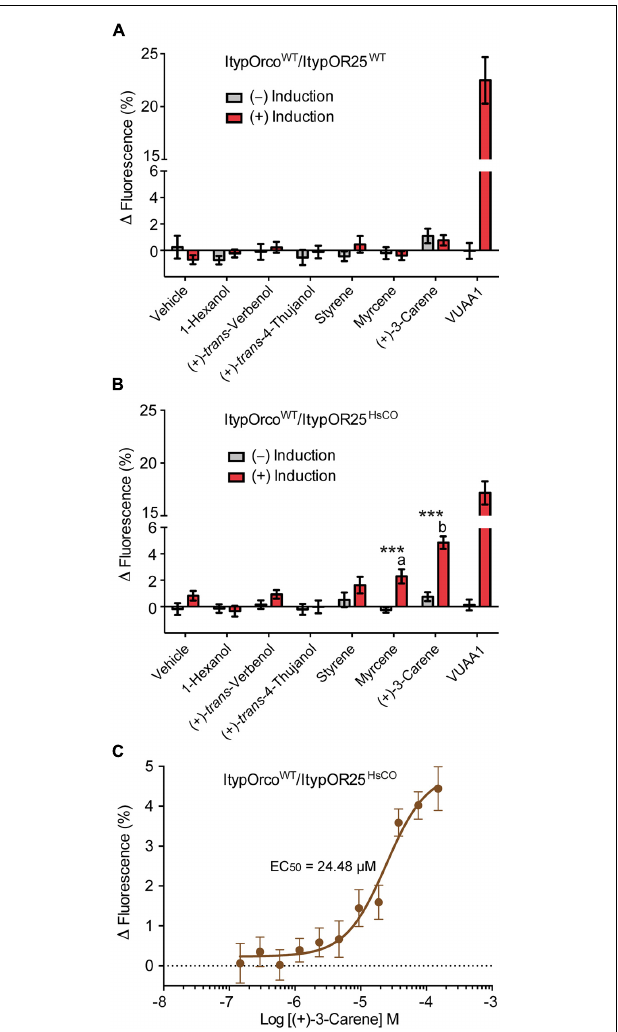
FIGURE 4 | Response of cells co-expressing wildtype I. typographus Orco (ItypOrco WT ) and wildtype or codon optimized (HsCO) ItypOR25 to select compounds. (A) ItypOR25 WT did not respond to any compound in the screening experiments (30 µ M concentration; n = 2 biological replicates; n total = 6). (B) ItypOR25 HsCO responded primarily to (+)-3-carene and secondarily to myrcene in the screening experiment ( n = 3 biological replicates, n total = 9). Asterisks (***) indicate significantly higher response in induced (+) versus non-induced ( − ) cells at p < 0.001, and different lowercase letters indicate significant differences between compounds at p < 0.001. (C) Dose-dependent response of ItypOR25 HsCO to (+)-3-carene ( n = 3 biological replicates; n total = 9). Error bars show SEM. Responses of ItypOR25 WT and ItypOR25 HsCO to the full odor panel are presented in Supplementary Figure 1